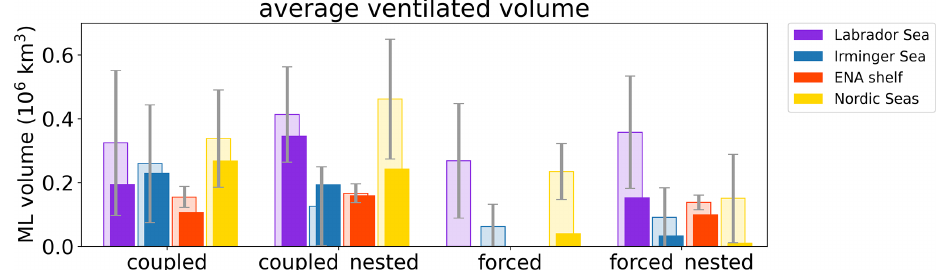
Figure 11. March-mean ventilated water volume for the reference state (pale bars in background) and perturbation experiment (in foreground) for regions with deep convection. Ventilated volume is computed as mixed-layer depth (MLD) times grid-cell area, where MLD > 500m. Gray error bars indicate ± 1 standard deviation of interannual